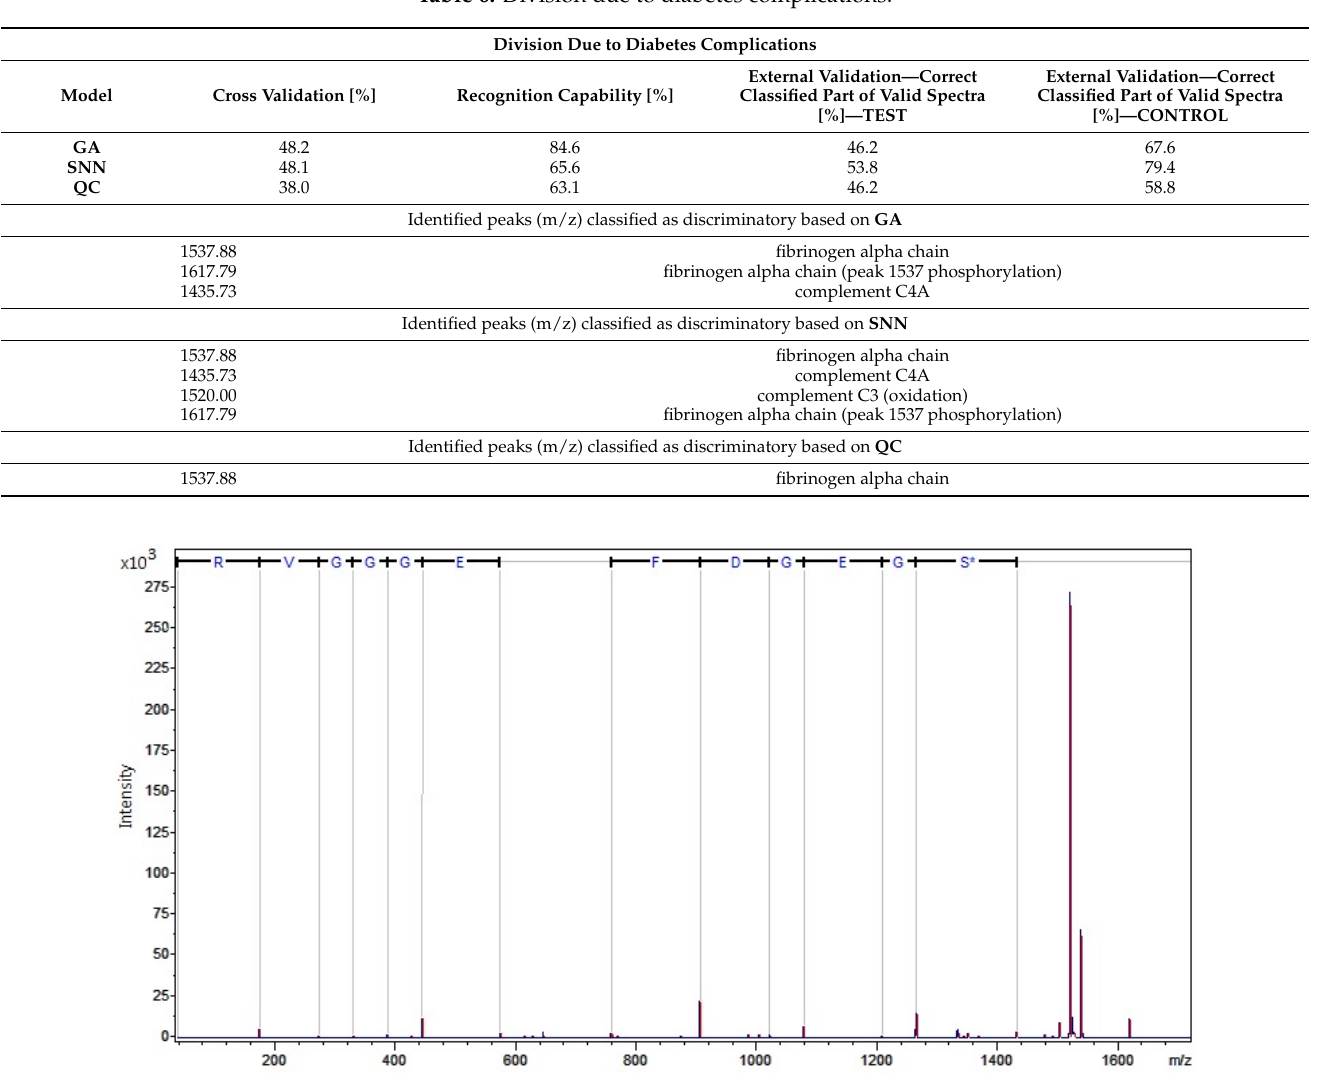
Table 6. Division due to diabetes complications.